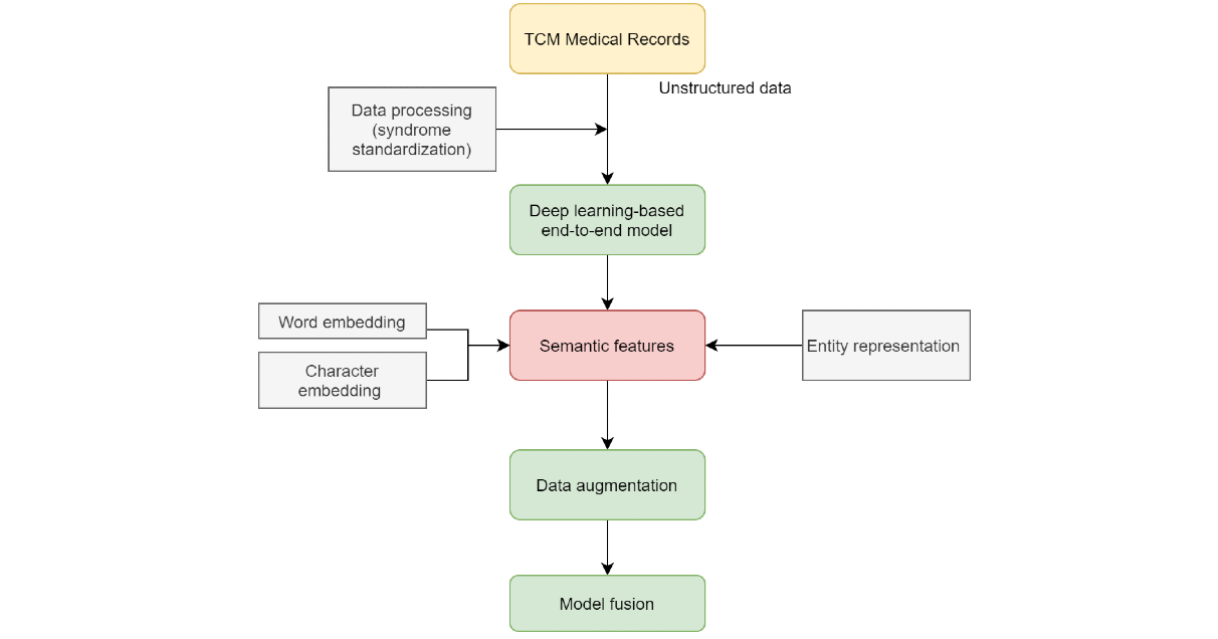
Figure 1. Framework of the end-to-end traditional Chinese medicine syndrome differentiation